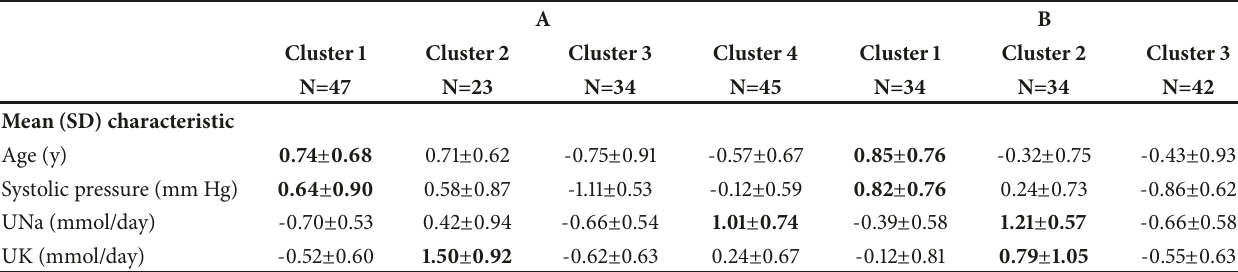
Table 3: Standardized means of age,systolic blood pressure,urinary sodium, and potassium ∗ excretion by clusterin wholesample (A;n=149) and in participants not using antihypertensive treatment (B; n=110).